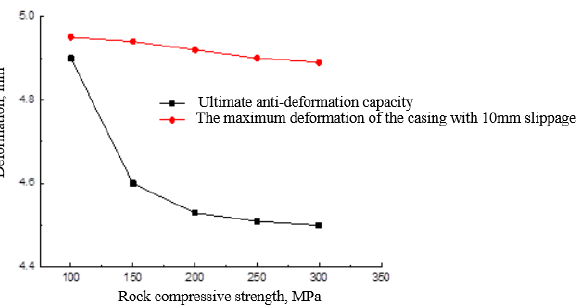
Figure 25. Curve of casing deformation resistance under different rock compressive strengths.